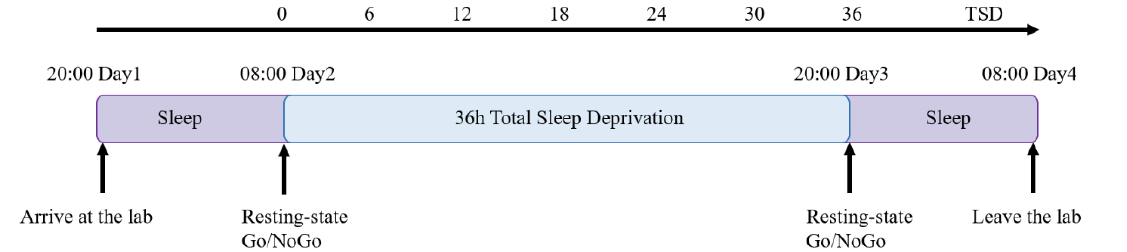
Figure 2. Flowchart showcasing the sleep deprivation experiment, with 60 h of experimental time. Participants entered the laboratory at 20:00 on the first night of the experiment and slept normally in the laboratory. The behavioral and electroencephalogram (EEG) data of the first resting-state and Go/NoGo task were collected at 08:00 on the second day (TSD: 0 h). On the third night, the behav- ioral and EEG data of the second resting-state and Go/NoGo task were collected after 35.5 ± 1.0 h of sleep deprivation (TSD: 36 h). Participants stayed in the laboratory for restorative sleep on the third night and left the laboratory at 8:00 a.m. on the fourth day.